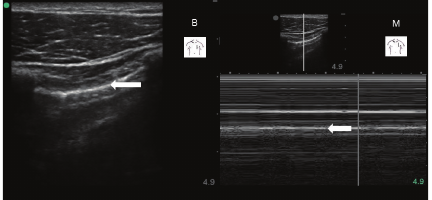
Figure 2: Healthy volunteer for comparison: B-mode and M- mode sonography using a linear transducer positioned in the mid- clavicular line at the 3rd intercostal space. Arrows indicate the pleural lines (B: B-mode, M: M-mode).